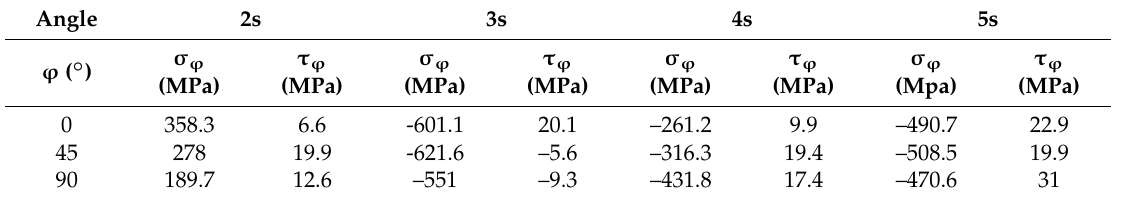
Figure 9. Analysis of d ϕψ vs sin 2 ψ . Table 3. Uniaxial stress analysis.